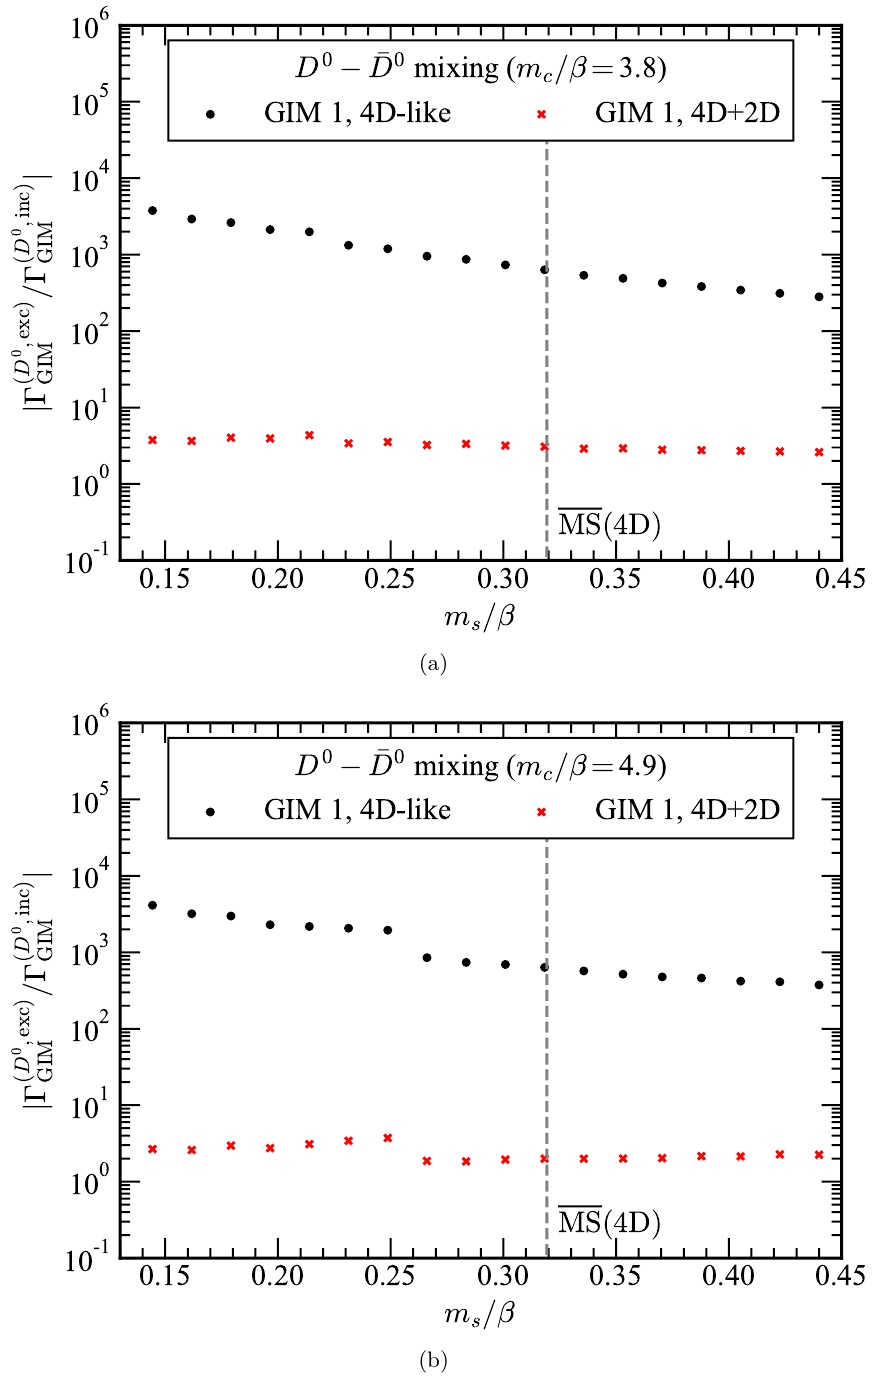
Figure 6 . Absolute values for the ratios of the exclusive GIM 1 in eqs. (2.11), (2.13) to the inclusive one for the D 0 − ¯ D 0 mixing: (a) m = 3 . 8 , (b) m = 4 . 9 . The black dot represents the case c /β c /β where only 4D-like phase space term in eq. (3.14) is considered in the inclusive calculation while the red cross corresponds to the case where both 4D-like and 2D-specific terms in eqs. (3.14)–(3.16) except for eq. (3.17) are